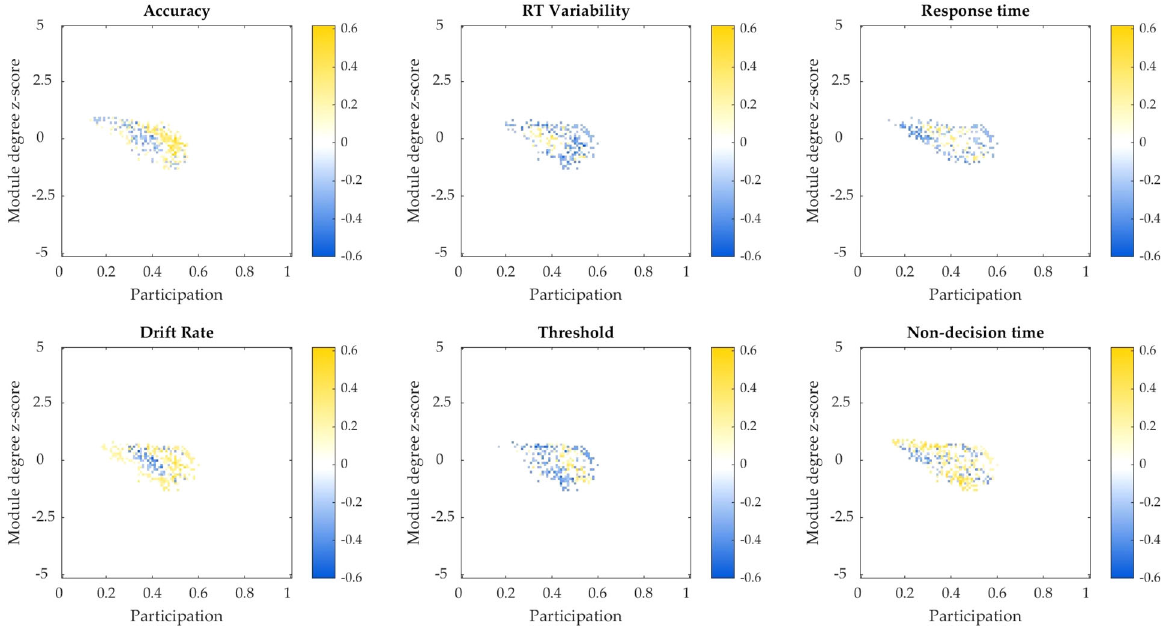
Fig. 4 Correlation between the cartographic topological pro fi le and attentional parameters from the SART. The cartographic pro fi le is a histogram mapping of the functional activity of each parcellated region of the brain according to the topological dimensions of between- module connectivity (participation) and within-module connectivity (module degree z score). Correlations displayed for regions with FDR < 0.2. Patterns of increased integration can be seen to positively map to higher accuracy and drift rate, while inversely mapping (negative correlation) with variability in response time (RT). Colour bar denotes Pearson ’ s correlation coef fi cient. RT response